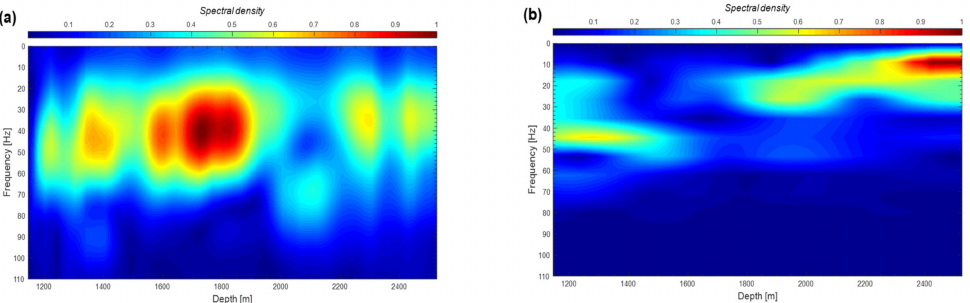
Figure 7. Spectrum of ( a ) VSP data recorded at an offset of 1300 m and ( b ) those obtained after applying Gabor transform with a filter width of 5 Hz and time to depth conversion, on OBC seismic data recorded at an offset of 1300 m.